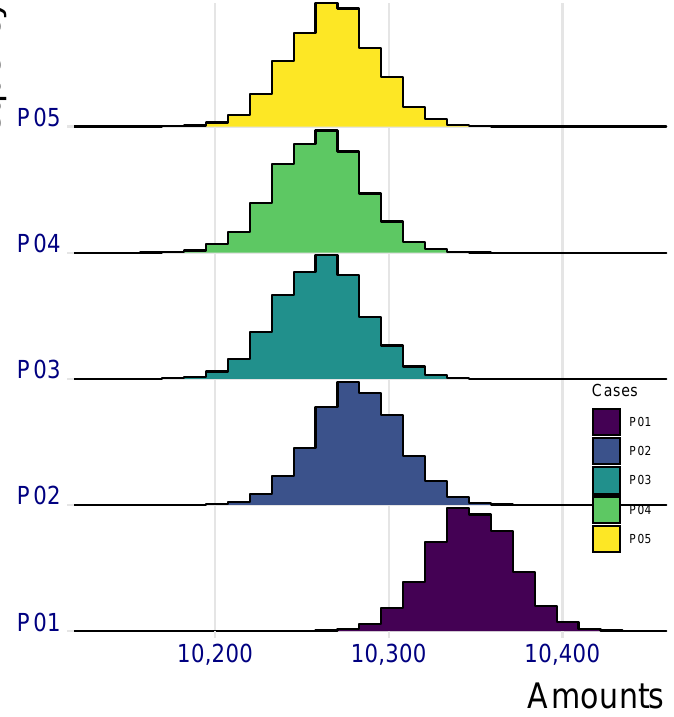
Figure 8. Impact of different dispersion parameters: empirical distributions of the total payout at time t =